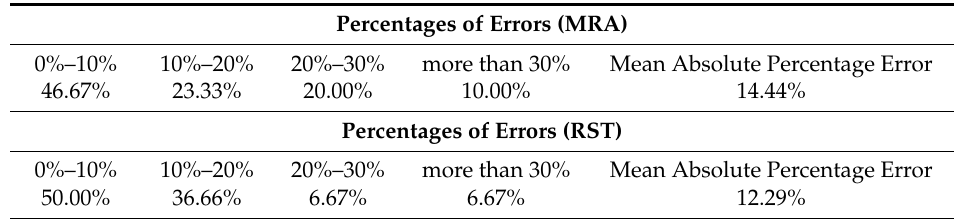
Table 11. Comparison between multiple regression analysis (MRA) and Rough Set Theory (RST) in terms of forecasting